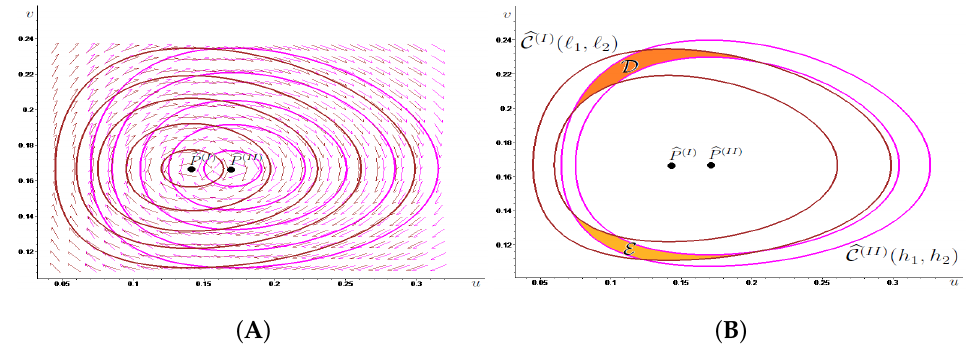
Figure 2. In ( A ) we draw in brown some energy level lines associated with System ( MI ) , around (cid:98) P ( I ) , and in magenta some energy level lines associated with System ( MII ) , around (cid:98) P ( II ) , also showing the corresponding phase portrait. In ( B ), we illustrate two linked together annuli, that we call (cid:98) C ( I ) ( (cid:96) 1 , (cid:96) 2 ) and (cid:98) C ( II ) ( h 1 , h 2 ) , obtained by suitably choosing two level lines for each system, as well as the two disjoint generalized rectangles D (colored in dark orange) and E (colored in light orange) where the annuli